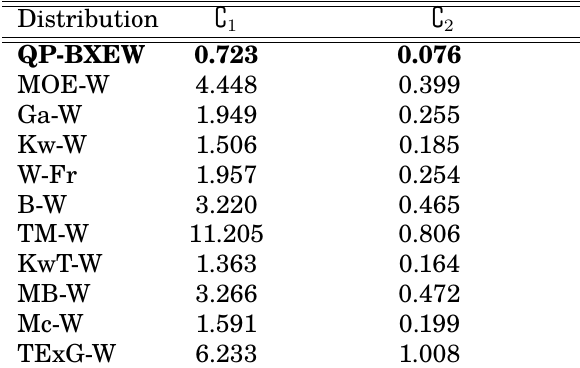
Table 3: (cid:123) 1 and (cid:123) 2 for the failure times data set.